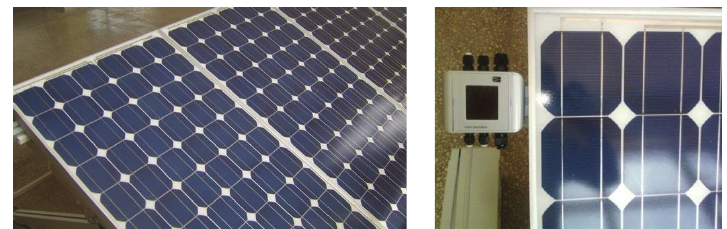
Figure 12: Used PV array for grid tied PV system.